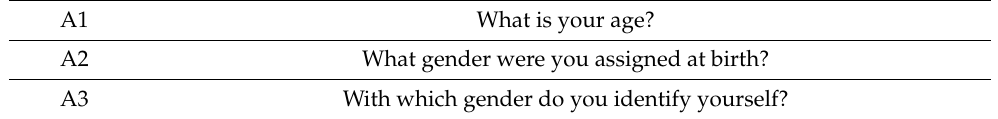
Table A1. Socio-demographic, health and lifestyle